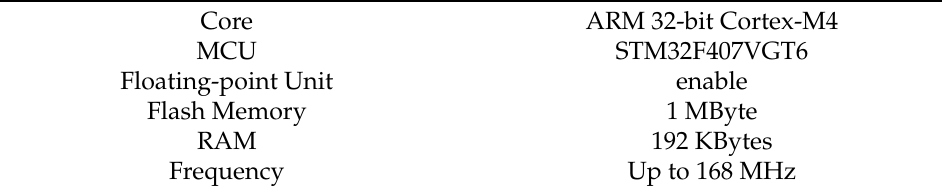
Table 1. Specification of STM32F4-Discovery embedded